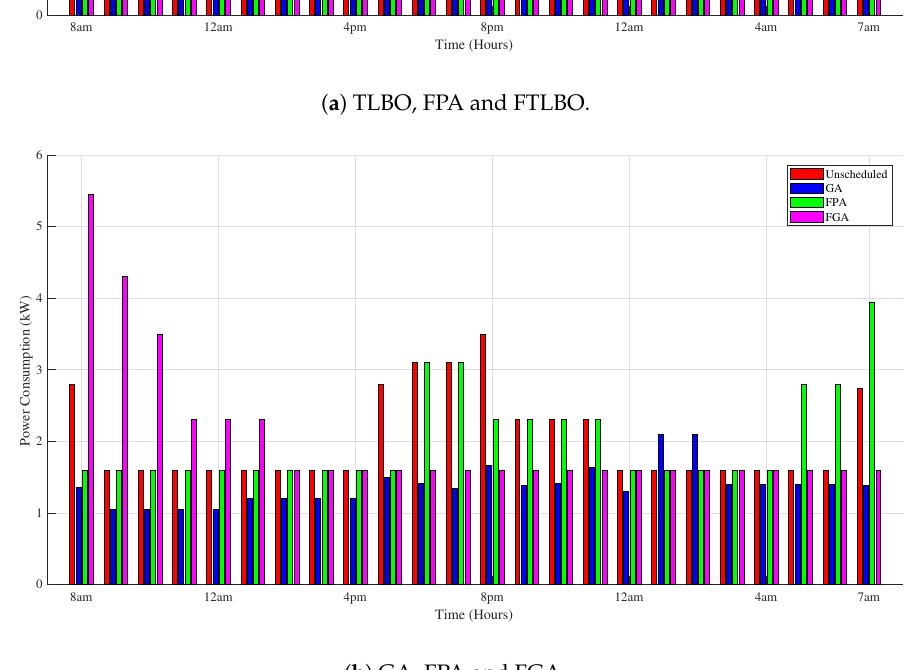
Figure 6. Hourly power consumption of appliances: ( a ) using TLBO, FPA and FTLBO, ( b ) using GA, FPA and